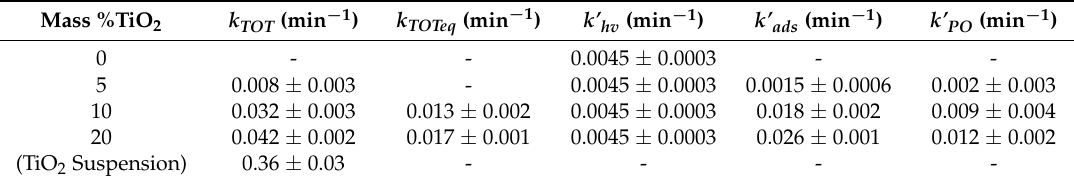
Table 3. Photocatalytic degradation rate constants for different beads produced in the study. The pseudo-first order rate constants for adsorption ( k’ ads ) and photolysis ( k’ hv ), elucidated by control experiments, contribute to the total removal of MB ( k TOT ); the fraction attributed to nonadsorption is assigned k TOTeq . The pseudo-first order rate constant k’ PO represents MB removal only by photocatalytic degradation which is found by using the kinetic model developed in this work. Errors listed for rate constants are standard deviations, calculated from three